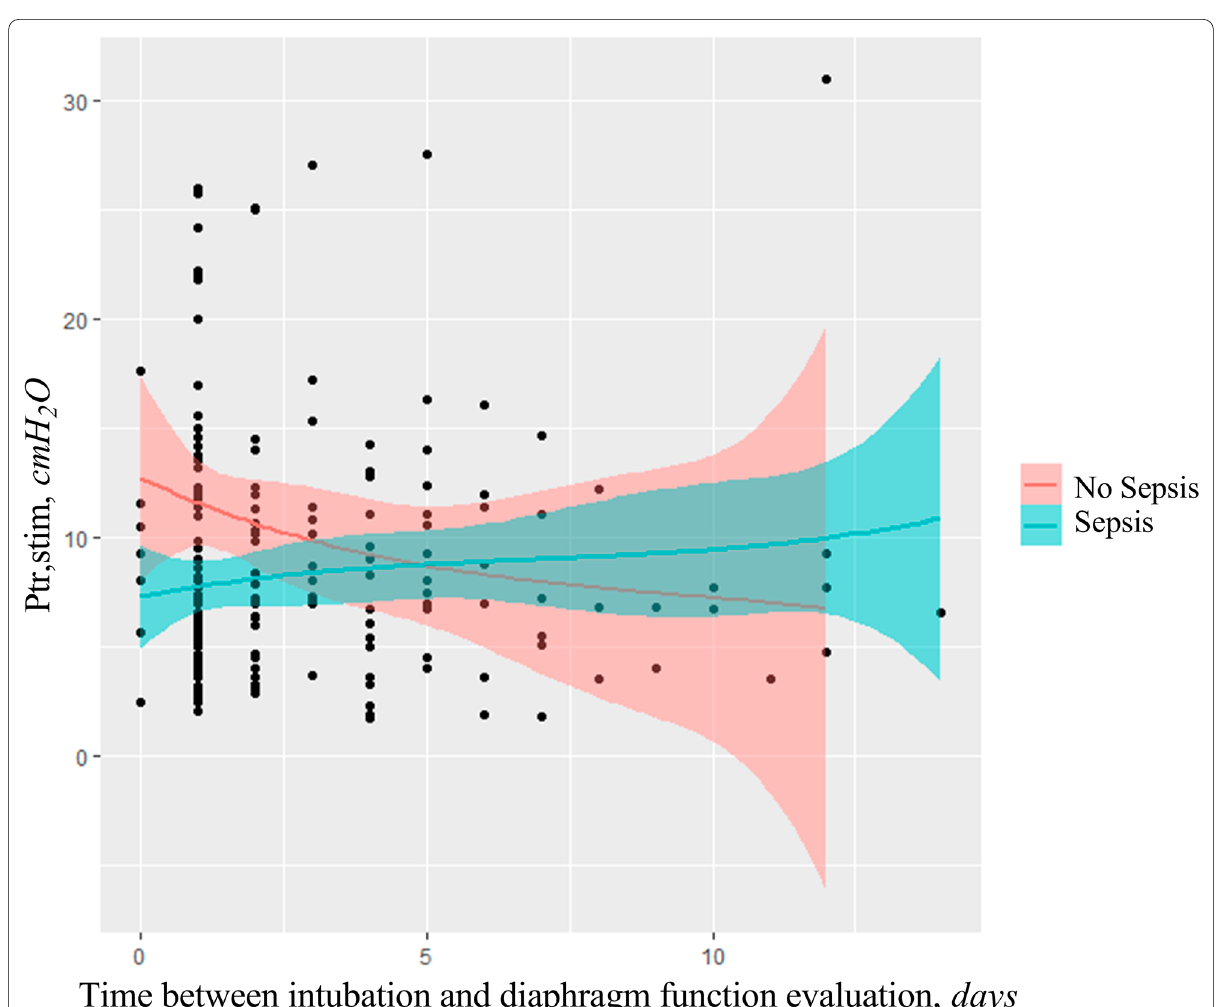
Fig. 2 Diaphragm function time course represented by endotracheal tube pressure induced by bilateral phrenic nerve stimulation during airway occlusion (Ptr,stim) according to time between intubation and measure in septic and non-septic patients. Each black circle represents a single measure of the diaphragm function for a given patient (184 circles in total). The lines represent the regression and the colored shaded areas represent 95% confidence interval for the regression curve